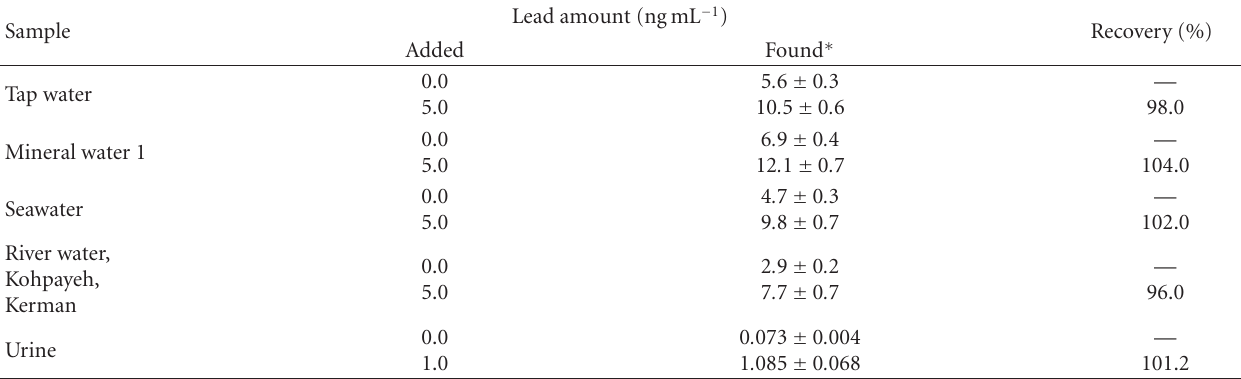
Table 3: Determination of lead in real